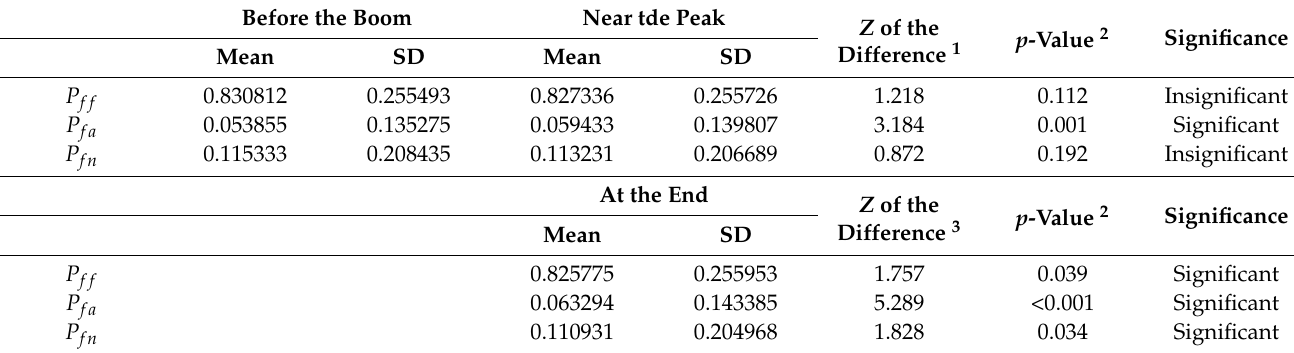
p -Value 2 Significance Difference 1